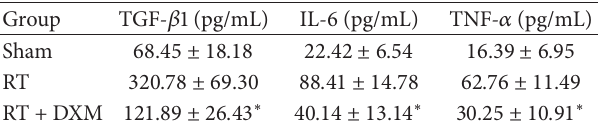
Table 3: The content of TGF- 𝛽 1, IL-6, and TNF- 𝛼 in BALF in each group ( 𝑛 = 8 , mean ± SD).